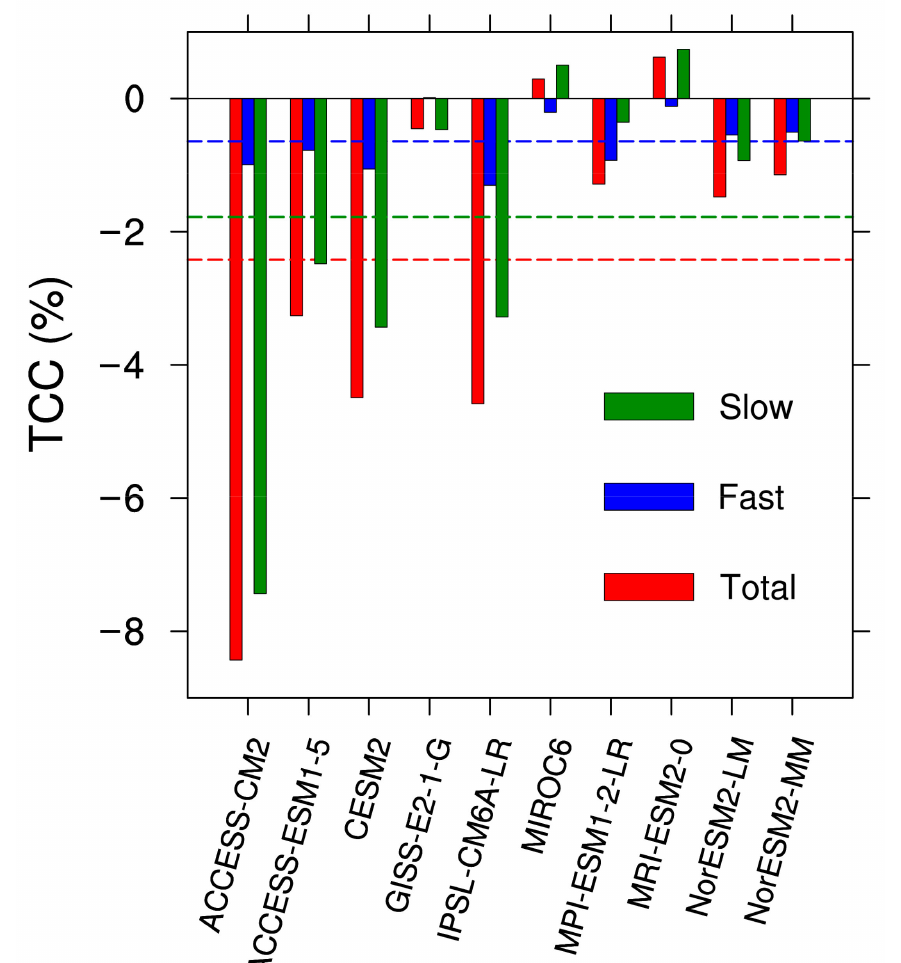
Figure 4. Responses of the global mean total cloud cover in 10 typical models (units: %). The red, blue, and green columns represent the total, fast, and slow responses, respectively, and the dotted lines represent the multi-model mean